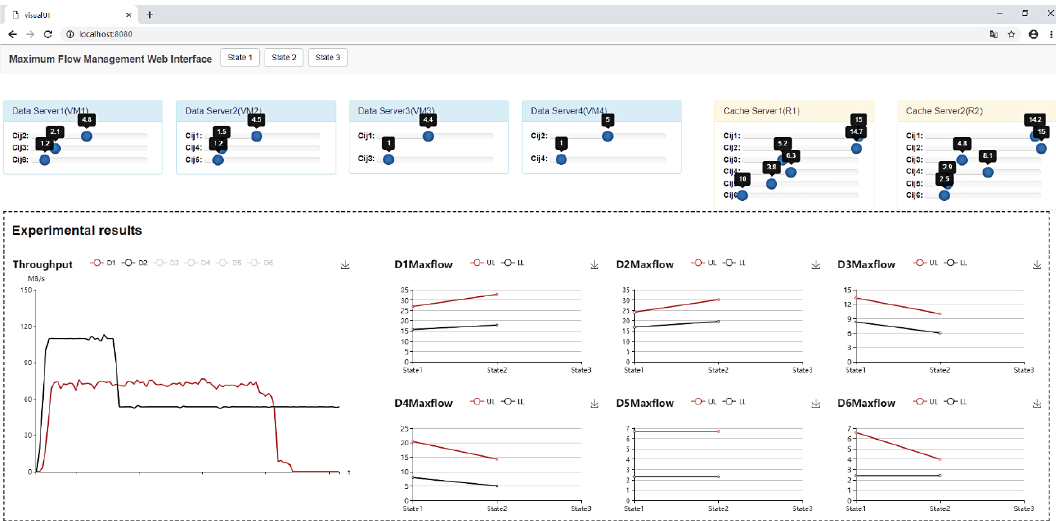
Figure 9. Web-based spatiotemporal data maximum flow management interface.